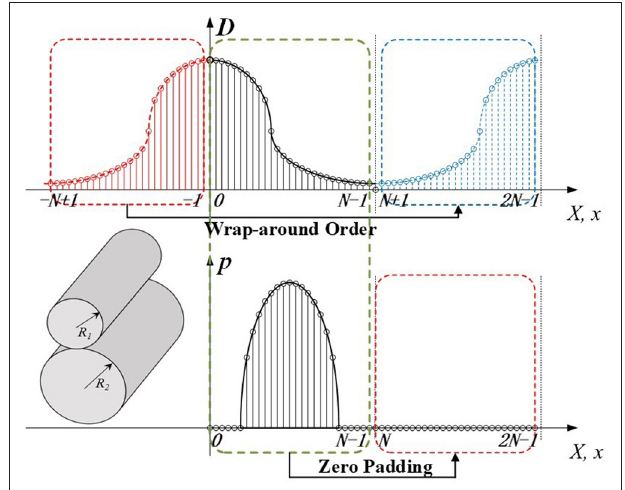
FIGURE 3 | 1D IC wrap around order and pressure zero padding for 2D line-contact